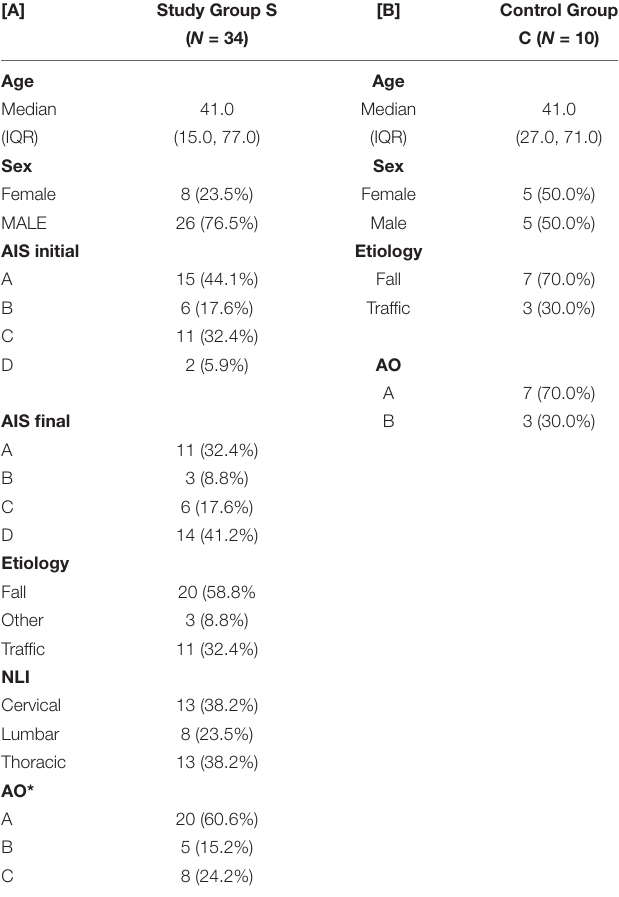
TABLE 1 | Descriptive depiction of patient characteristics of subjects in the study group S and the control group